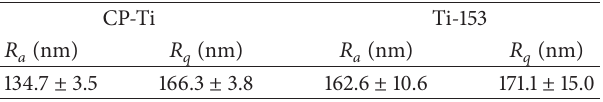
Table 2: Surface roughness of CP-Ti and Ti-153 sheet specimens before hydrogenation. CP-Ti Ti-153 𝑅 𝑅 𝑅 𝑅 𝑎 (nm) 𝑞 (nm) 𝑎 (nm) 𝑞 (nm) 134.7 ± 3.5 166.3 ± 3.8 162.6 ± 10.6 171.1 ± 15.0